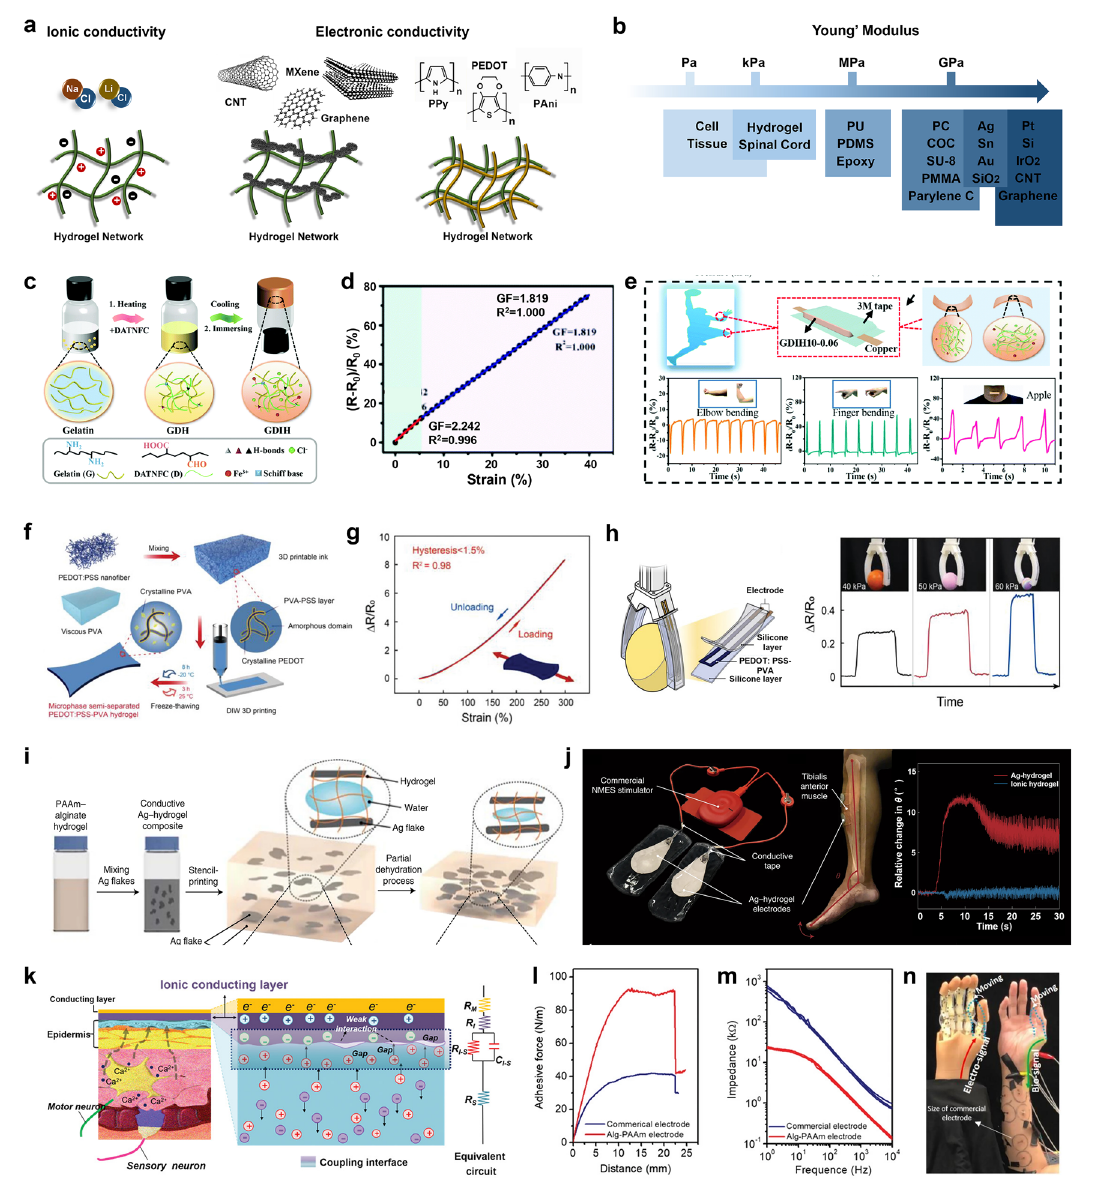
Fig. 6 Hydrogel-based soft devices. a Material design of ICHs and ECHs. b Young’s moduli of common electrode materials and cell/tissue. c Schematic illustration of the preparation and internal structure of conductive gelatin/nanofibrillated cellulose/Fe 3+ hydrogels, and the relative resistance changes and GF with the increase of tensile strain ( d ), as well as their applications in monitoring elbow flexion, index finger flexion, throat vibration ( e ). Reproduced with permission [179]. Copyright (2022), Royal Society of Chemistry. f Principle and fabrication process of the PEDOT:PSS-PVA conducting polymer hydrogel, and the loading and unloading resistance responses of the PEDOT:PSS-PVA hydrogel strain sensor with a strain of 300% ( g) , as well as its application as robotic skins for sensory grasping ( h ). Reproduced with permission [178]. Copy- right (2022), Wiley–VCH. i Schematic of the electrode and skin for sEMG and coupling process of the ionic fluxes in electrolytic tissue media and electronic current in the recording electrode. j 90° peel-off test of electrode based on Alg-PAAm gel and commercial gel. k Contact imped- ance verse frequency of the Alg-PAAm electrode and commercial electrode. l Needle grasping driven by sEMG signals obtained by as-prepared Alg-PAAm electrodes. Reproduced with permission [181]. Copyright (2020), Wiley–VCH. m Composition and synthesis of the conductive hydrogel composite composed of micrometer-scale Ag flakes and PAAm-alginate hydrogel (Ag-hydrogel composite). n Neuromuscular electri- cal stimulation electrodes made of the Ag-hydrogel composite with a commercial electrical muscle stimulator, and the relative changes in dorsi- flexion angle as a function of stimulation time. Reproduced with permission [172]. Copyright (2021), Nature Publishing